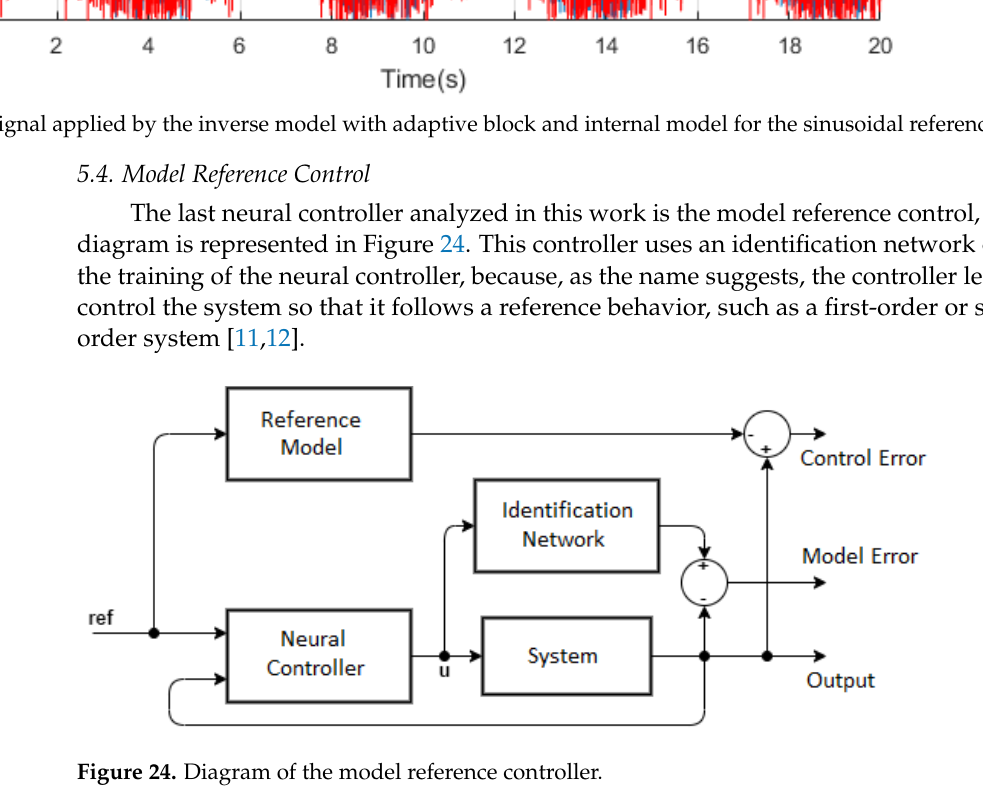
Figure 24. Diagram of the model reference